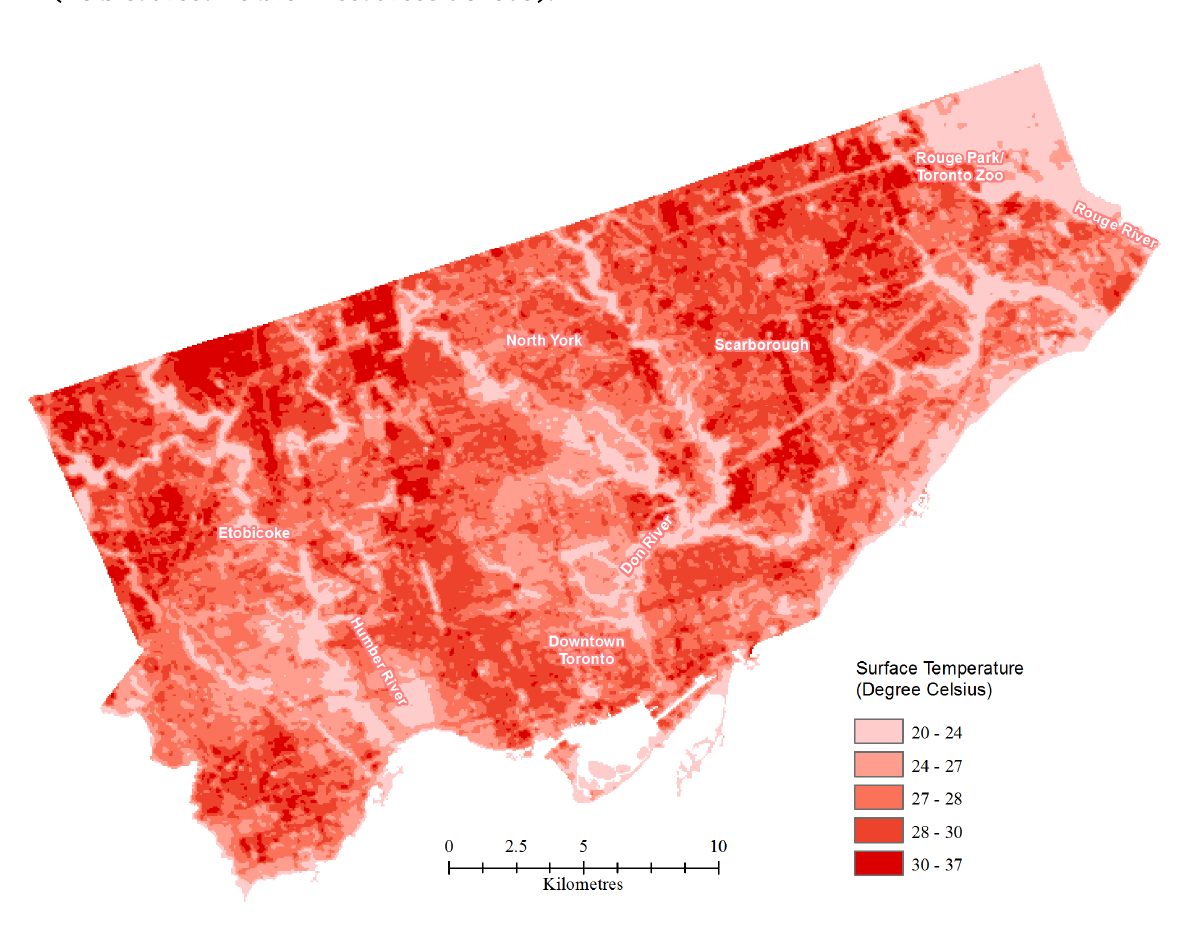
Figure 2. Surface temperature across the City of Toronto at 10:00 am on 3 September 2008 (Data source: Natural Resources